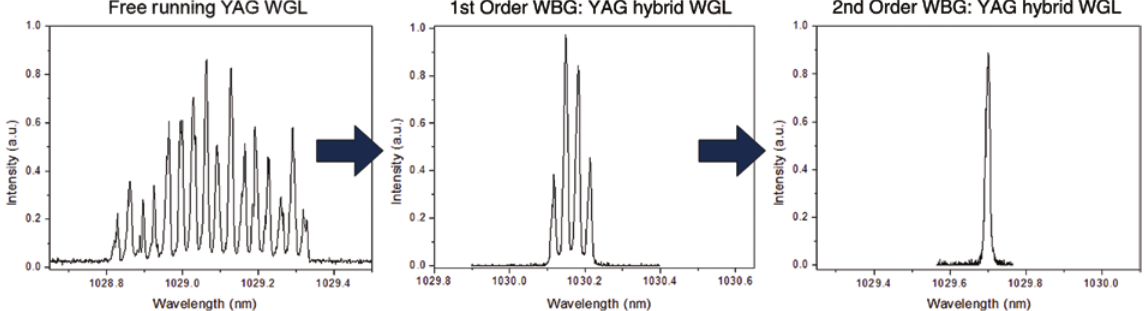
Figure 21: (Left) Broadband, multimode laser emission from a resonator formed between the Fresnel reflection of a Yb:YAG pump input facet and a thin high reflecting (HR) mirror at the other facet. Laser emission from the hybrid integration of an Yb:YAG WGL with (middle) a broad first-order WBG high reflector and (right) a narrow second-order WBG high reflector.